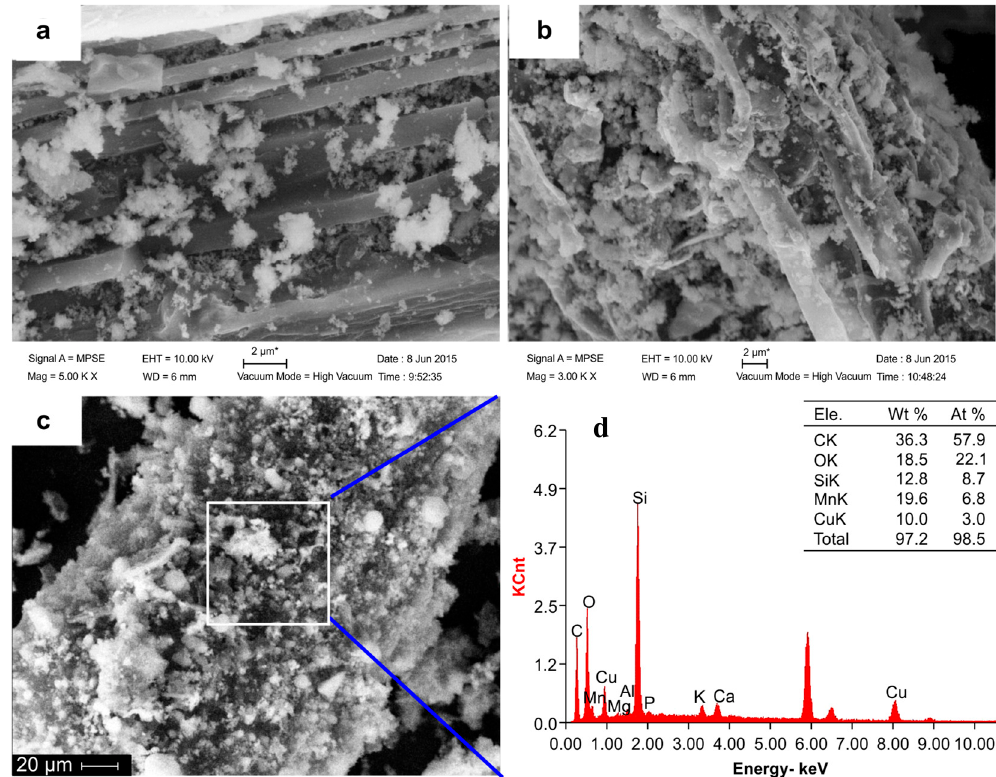
Figure 1. SEM images of the nano-MnO 2 –biochar composites (NMBCs) ( a ) NMBCs before the adsorption of Cu; ( b ) the NMBCs after adsorption of Cu; ( c ) SEM-EDS image of the NMBCs after the adsorption of Cu; and ( d ) the EDS test result after the adsorption of Cu.